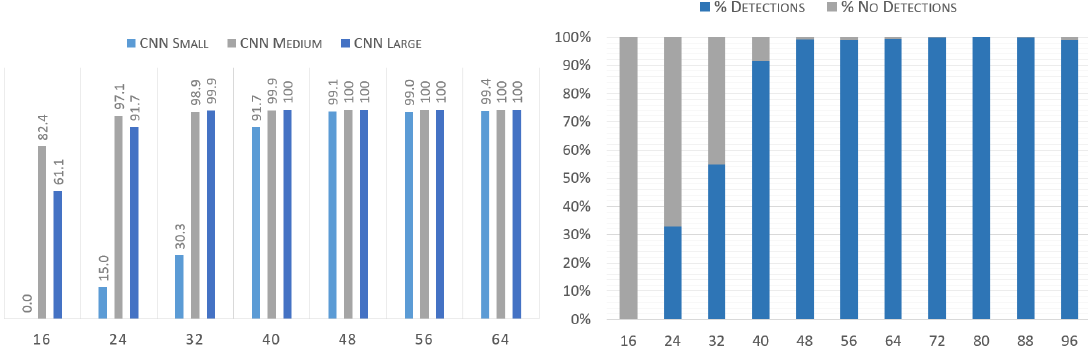
Figure 11. Image resolution and ear size sensitivity: ( Left ) Individual CNNs, ( Right ) 3-CNN